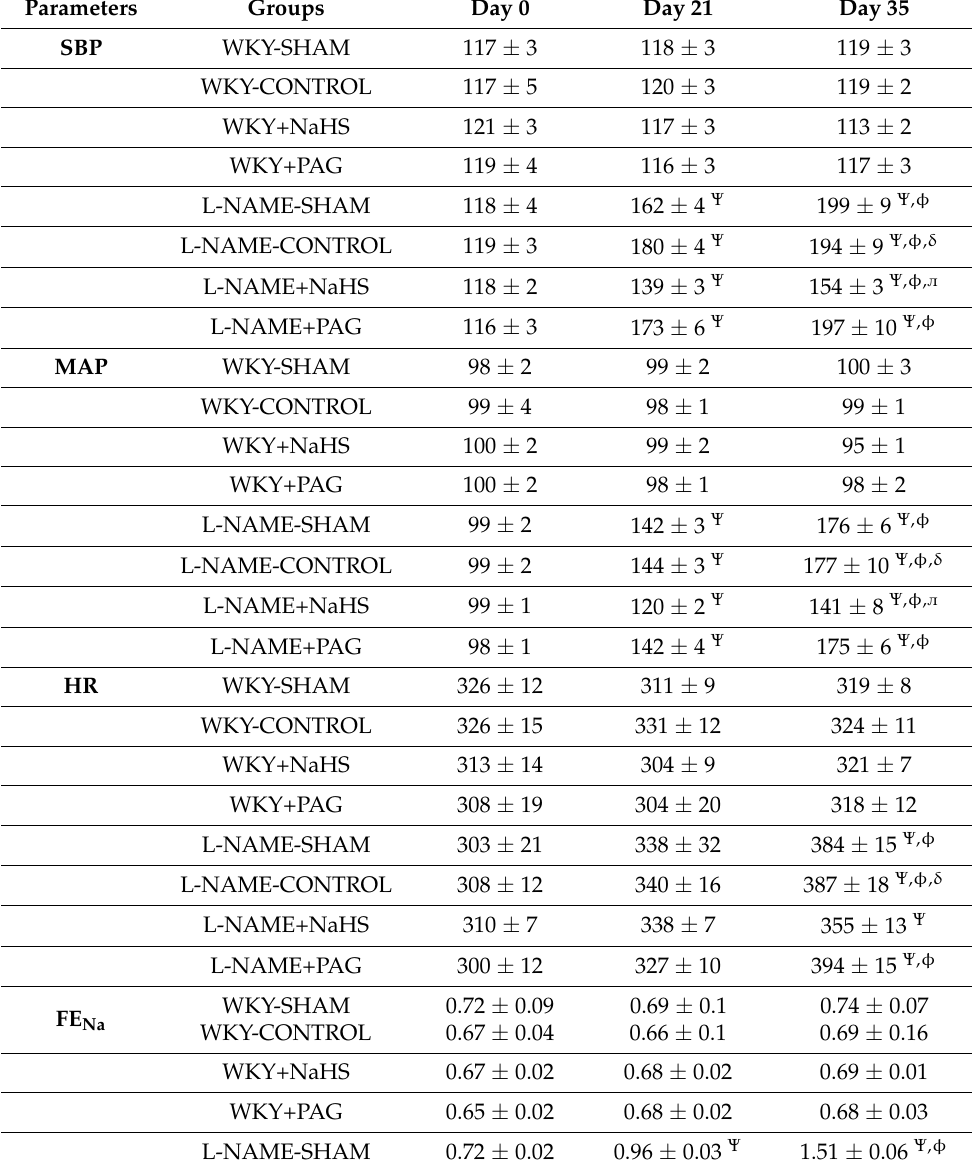
Table 1. Hemodynamics and renal functional parameters in all experimental groups of WKY and L-NAME rats during metabolic collection on days 0, 21 and